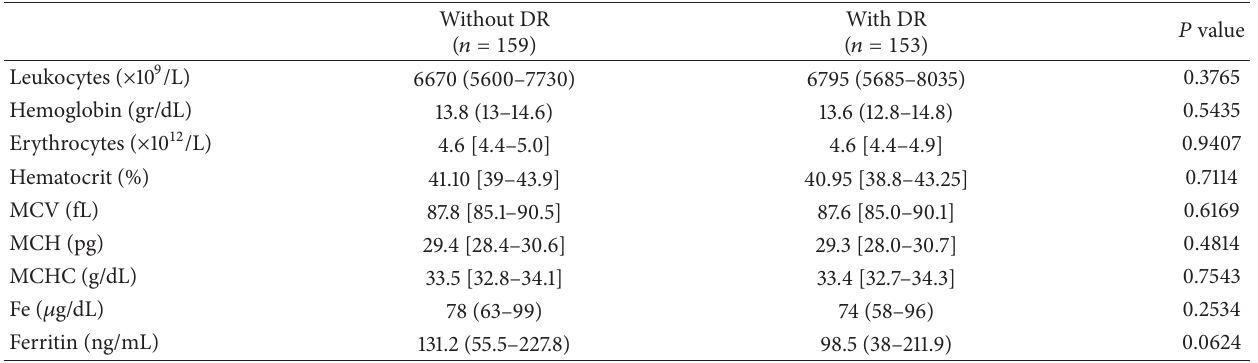
Table 1: Hematological variables of the study groups according to presence or absence of diabetic retinopathy (DR).